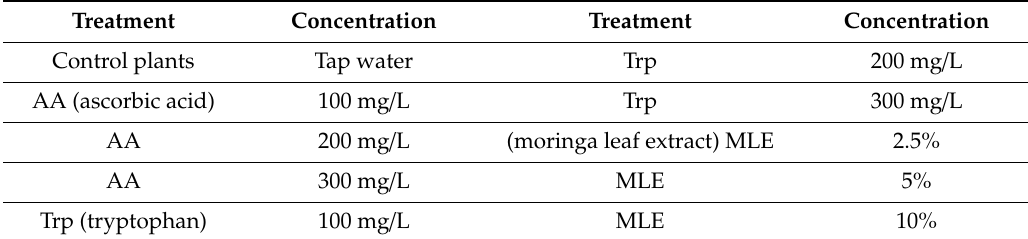
Table 10. Di ff erent treatments used and their concentrations. Treatment Concentration Treatment